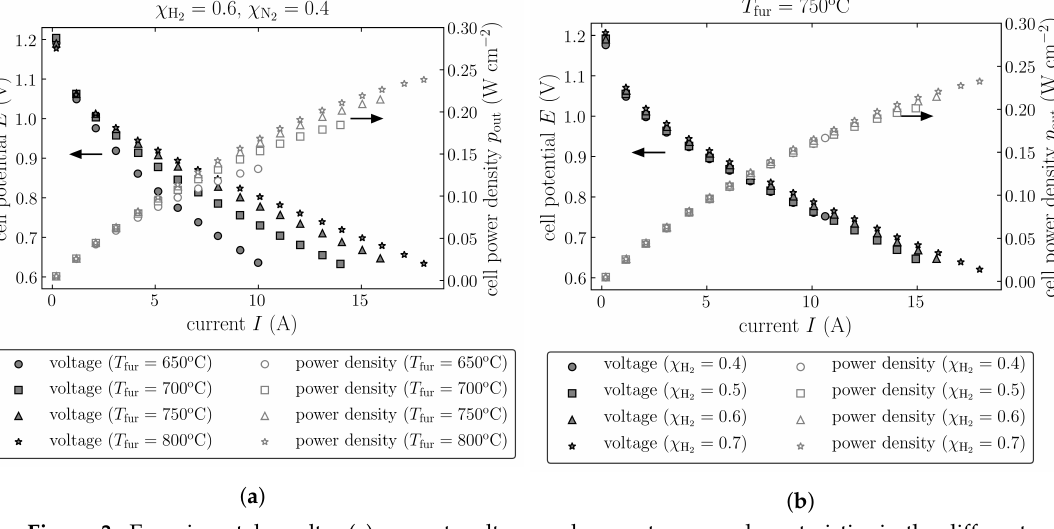
Figure 3. Experimental results. ( a ) current–voltage and current–power characteristics in the different furnace temperatures; ( b ) current–voltage and current–power characteristics for the different fuel